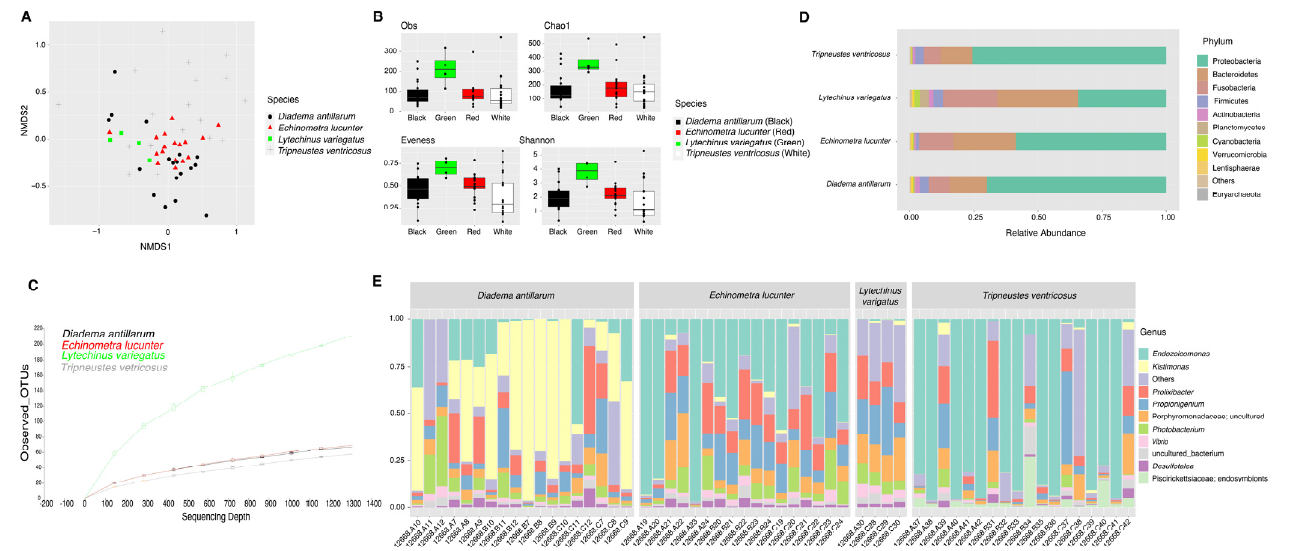
Figure 1. Bacterial composition and diversity of four sea urchin species. Bray–Curtis analysis, represented by an NMDS (stress = 0.212), using species as metadata categories, depicts distinct species clustering with ANOSIM p val = 0.001 ( A ). Alpha diversity analyses revealed significant differences ( p value < 0.05) in alpha diversity (Shannon) and richness (Chao1 and Observed species) analyses between species when compared to L. variegatus (green sea urchin) ( B ). Panel ( C ) depicts rarefaction curves at the species level. Species-relative abundance of top ten taxa at phyla ( D ) and genus levels ( E ) are depicted by the barplots. For significant p-values refer to Supplementary Table S3.